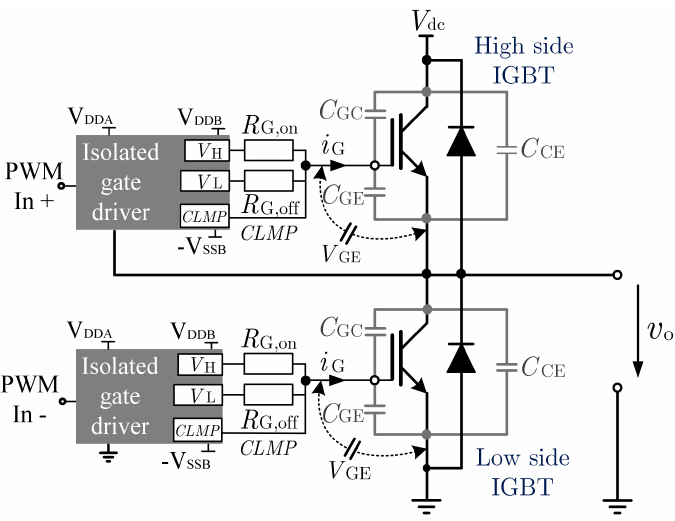
Figure 7. HB cell with basic push-pull resistive gate drives and parasitic capacitances of the